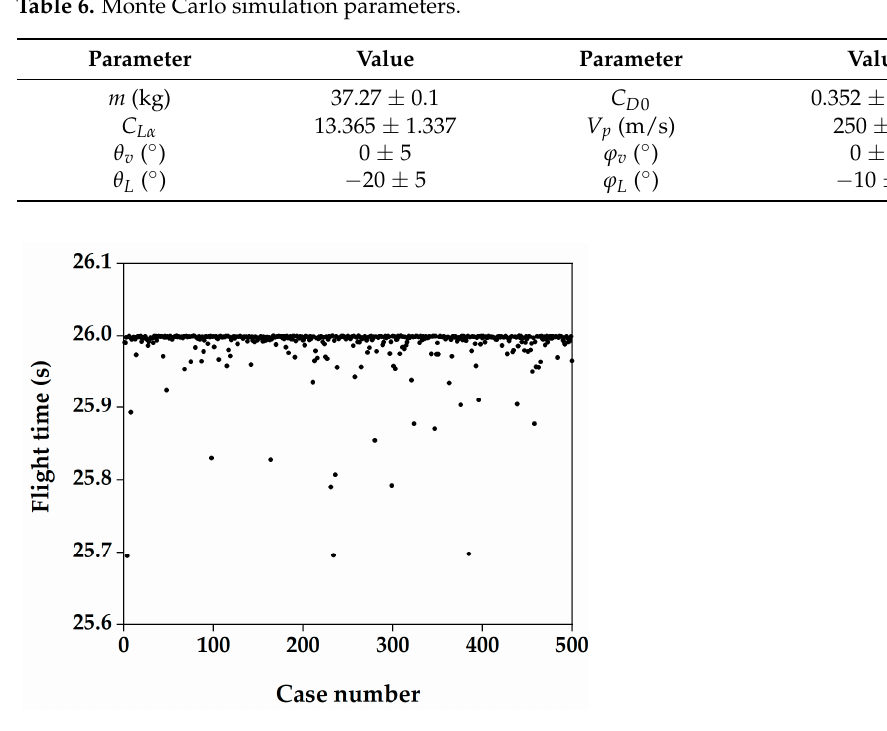
Figure 8. Flight time under Monte Carlo simulation.